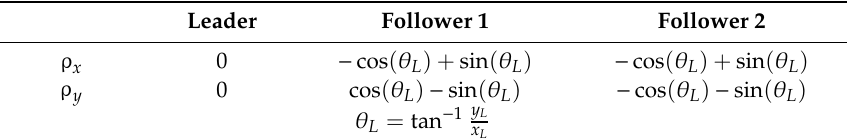
Table 11. The x and y reference states.